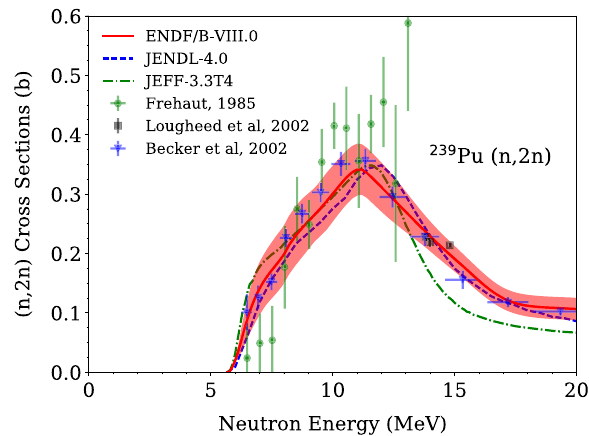
Fig. 1. The ENDF/B-VIII.0 evaluated 239 Pu( n , 2 n ) cross section and one-sigma uncertainty band are shown in comparison with several experimental data sets.